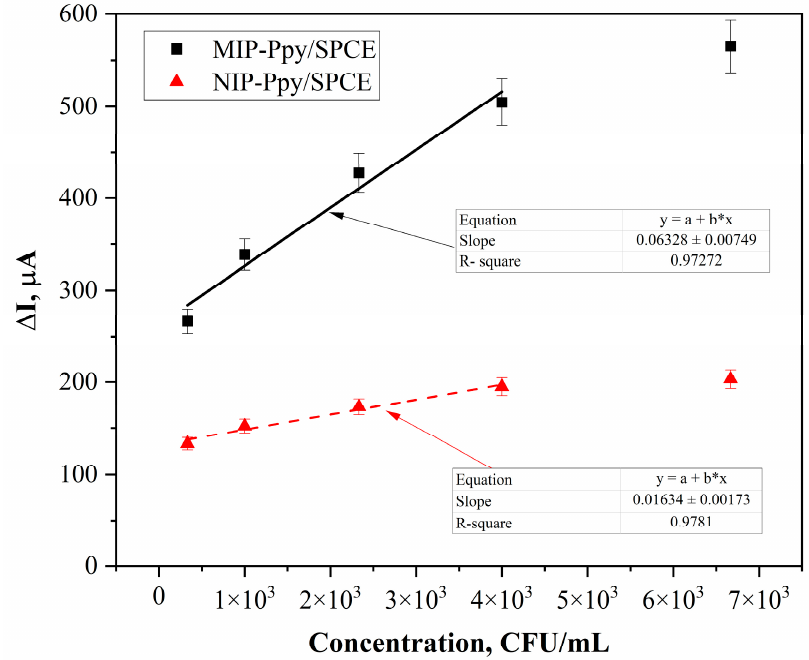
Figure 7. Calibration curve ∆ I registered by MIP-Ppy/SPCE (black line) and NIP-Ppy/SPCE (red line) vs. Listeria monocytogenes concentration. Error bars are calculated as a percentage standard error.